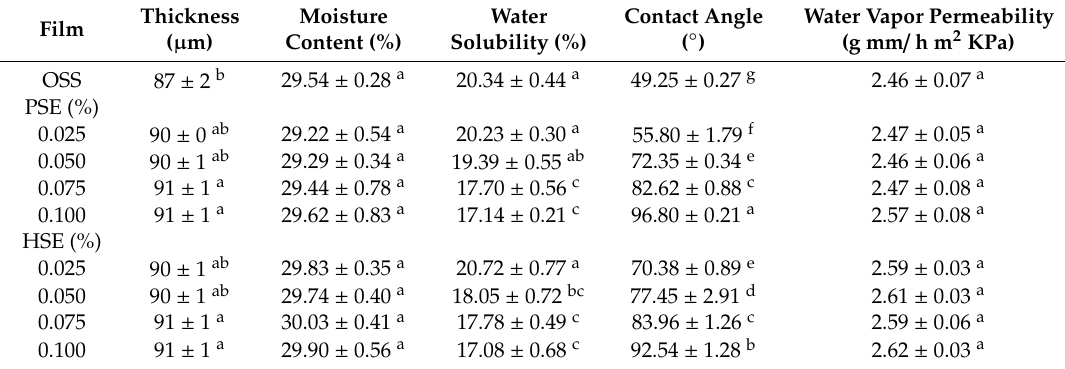
Table 3. Thickness, moisture content, water-solubility, contact angle, and water vapor permeability of octenyl succinate starch